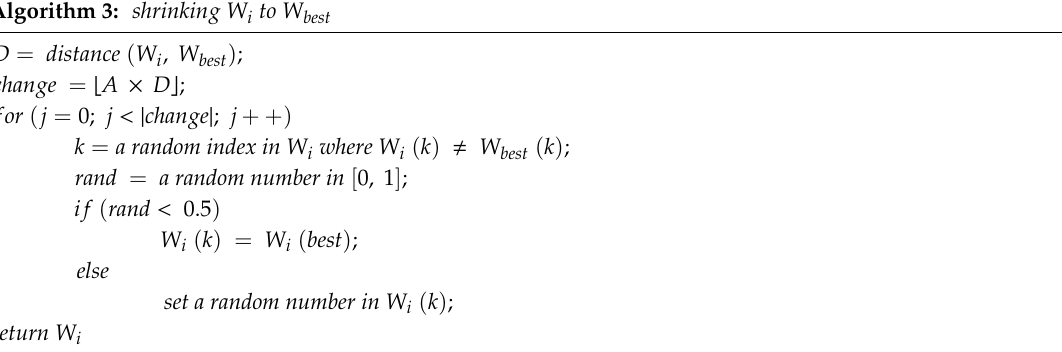
Algorithm 3: shrinking W i to W